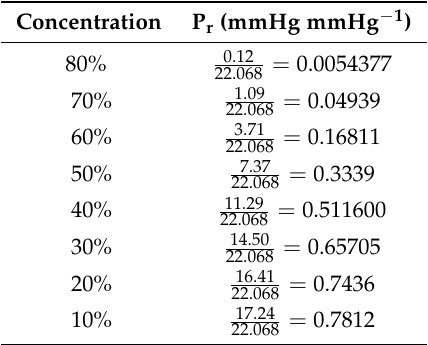
Table A5. Relative pressure at different concentrations ( H 2 O / H 2 SO 4 mixture) at temperature of 23 ◦ C.